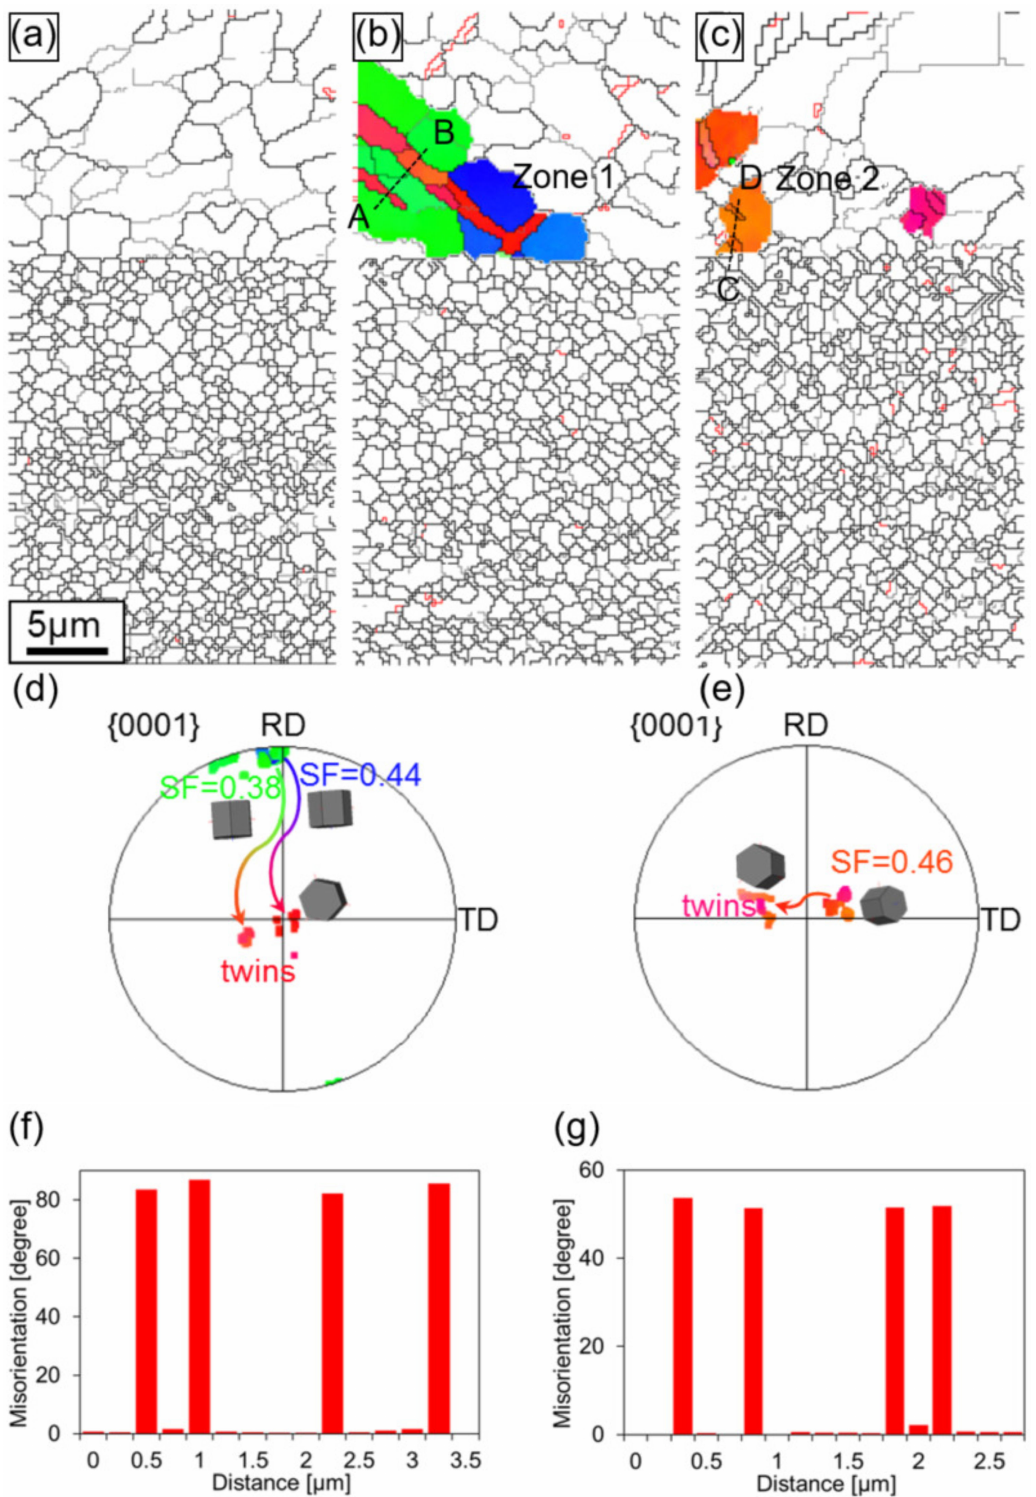
Figure 14. Twin boundaries in the ZK60 / WE43 composite rod for extension twinning {10-12} < 10-11 > modedefinedinthemapswitharedcolorasspecifiedbasedupontheexpectedtwin-parentrelationships. ( a ) initial undeformed state (0%), ( b ) compressive yield point (1.1%), and ( c ) compressive “ultimate” point (9.4%); ( d , e ) crystallographic orientations of the selected grains in ( b ) and ( c ); ( f , g ) misorientation profile along the direction determined by line A-B and C-D in ( b ) and ( c